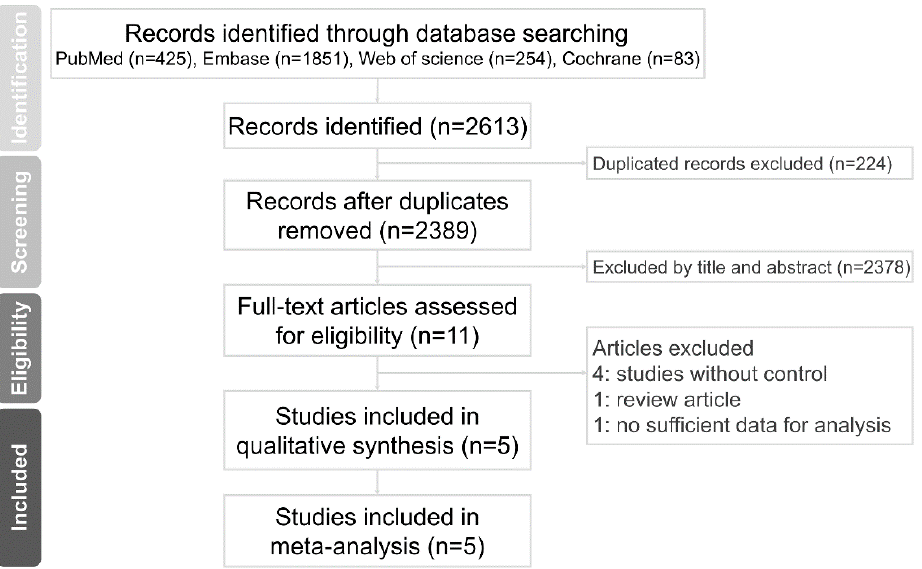
Figure 1. PRISMA flow diagram.